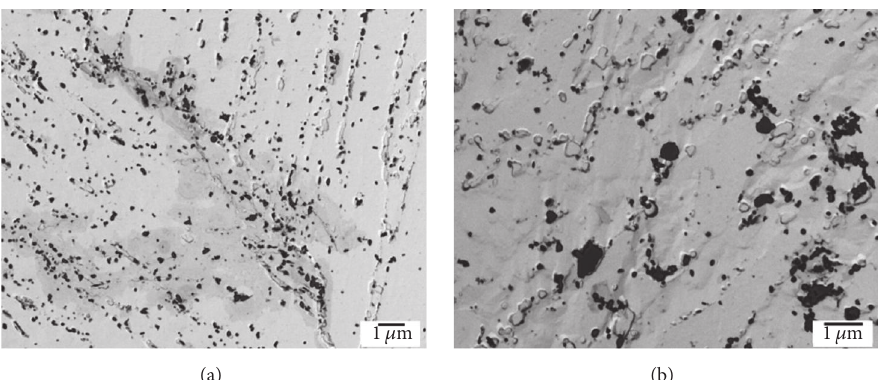
Figure 6: TEM carbon extraction replica visualization of secondary phase precipitates in WM of studied CB2 weldment in PWHT state (a) and after 30 kh ageing at 625 ∘ C (b).